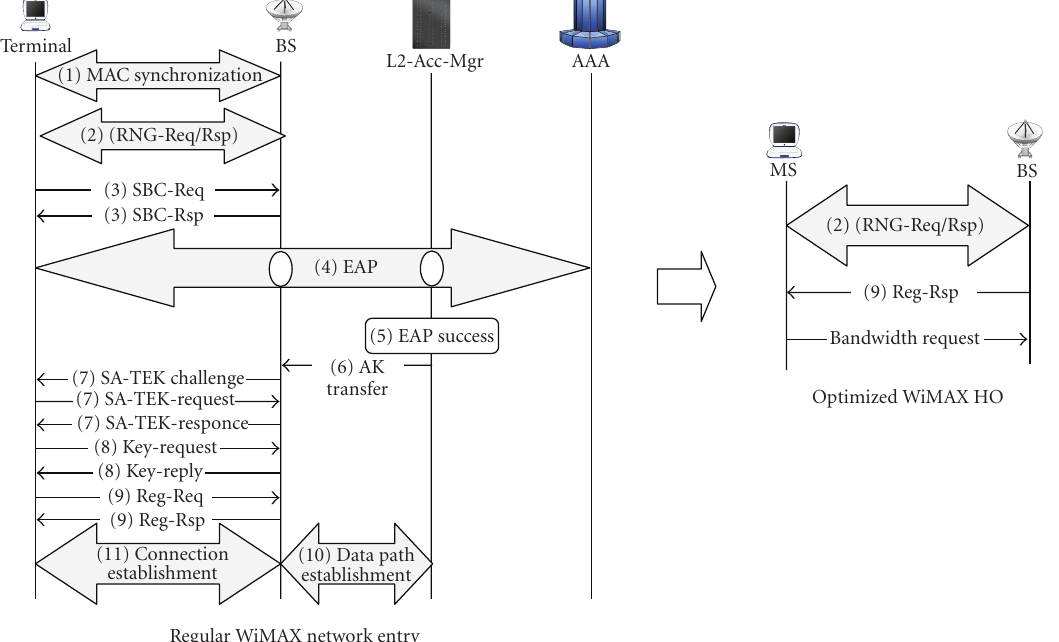
Figure 11: Association versus Re-association with a WiMAX Base station.